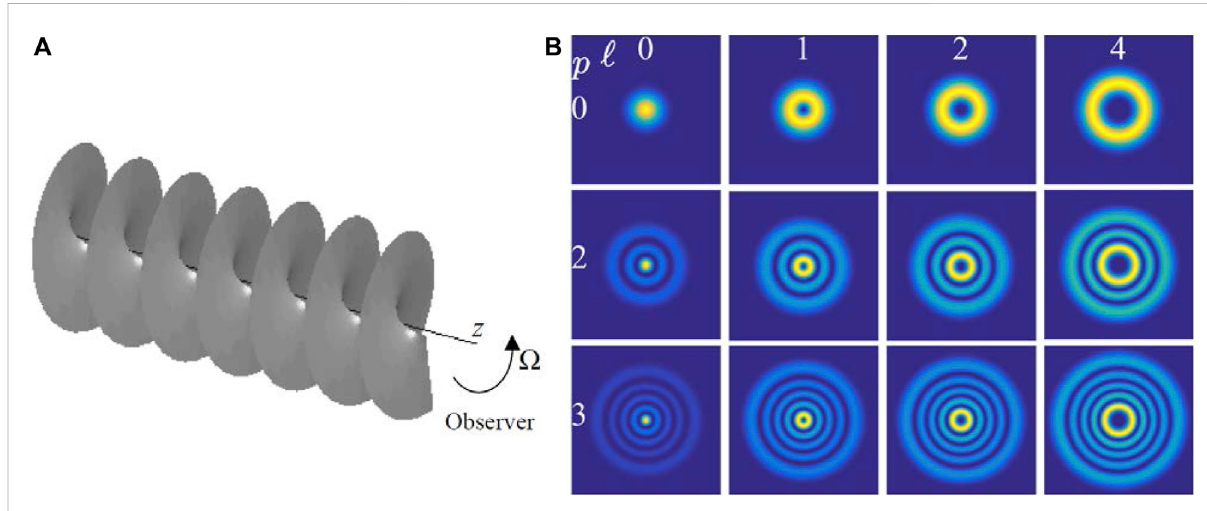
FIGURE 1 (A) ThehelicalWFoftheazimuthalharmonic(3)propagatingalongaxis z ; (B) theintensitypro fi lesoftheLG p l beamsfordifferentvaluesof l and p [38]; further explanations see in the